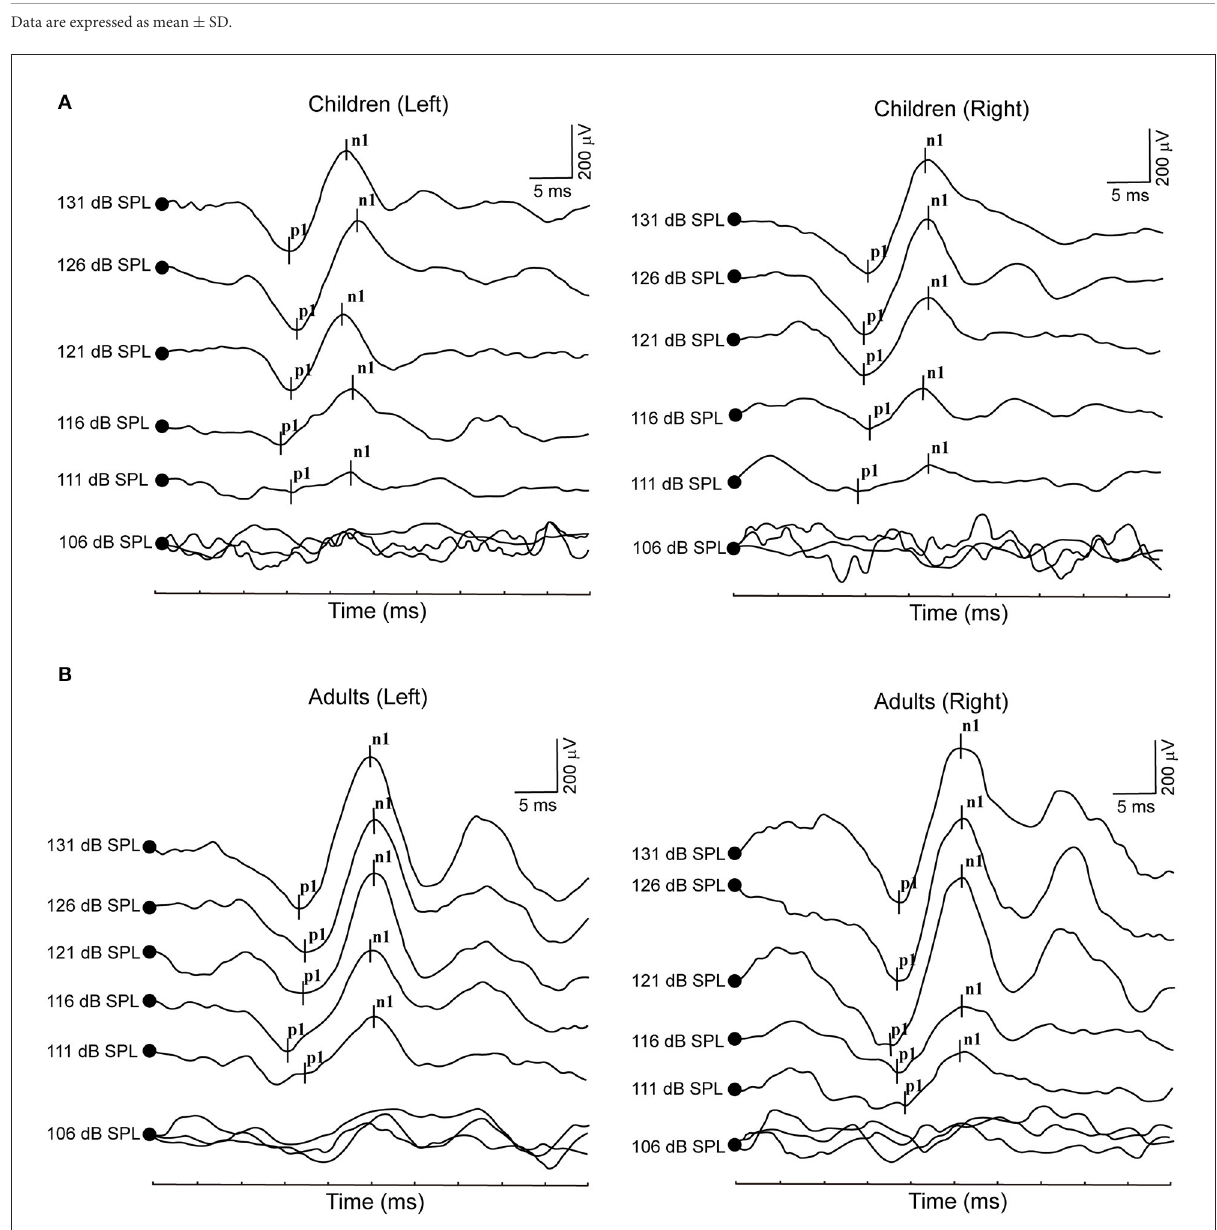
FIGURE2 (A) Clear cVEMP waveform in a child in response to ACS stimuli. (B) Clear cVEMP waveform in an adult in response to ACS